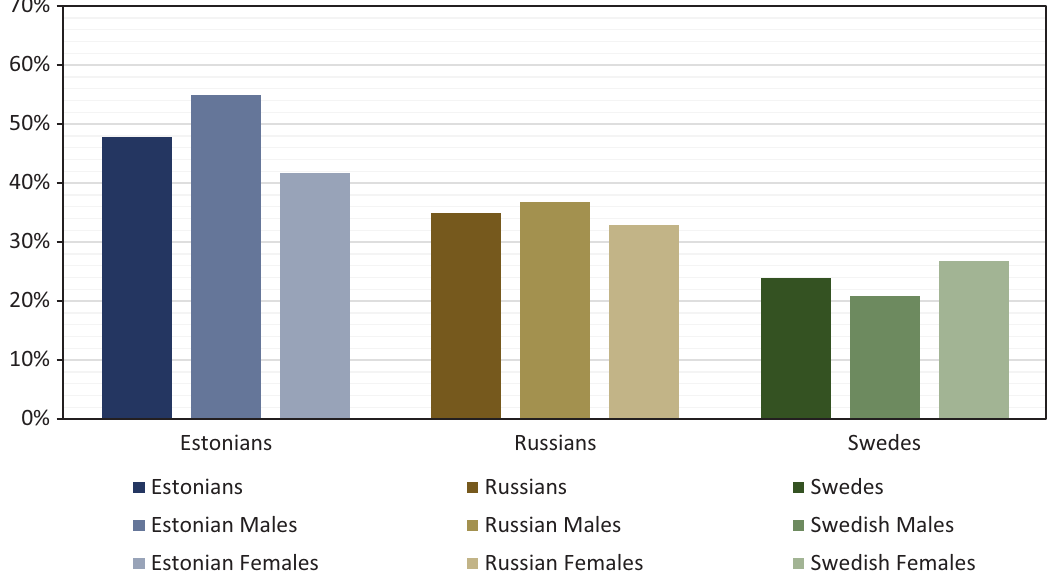
Figure 2. The average share of migrants as co-workers across ethnic groups (total, for males and females) in 2013. Source: Authors’ own calculation based on Finnish registry data set (year 2013) not publicly